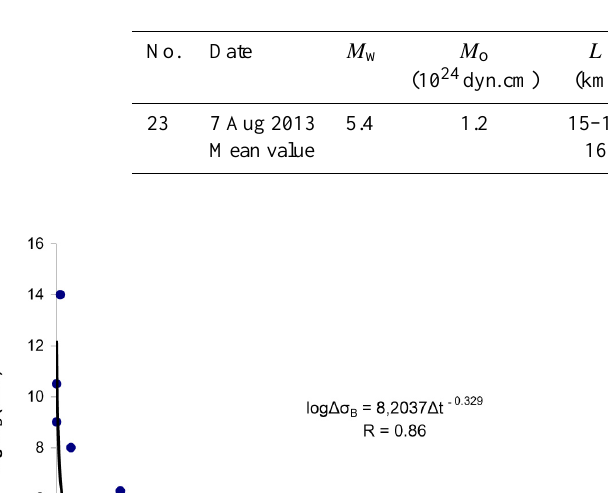
Table 1. The USGS-reported date and magnitude of the main shock along with its seismic moment, range of values in the dimensions of the aftershock areas L and W , the corresponding calculated values for 1σ B , the critical exponent α and the lead time 1t . Mean values are also given.